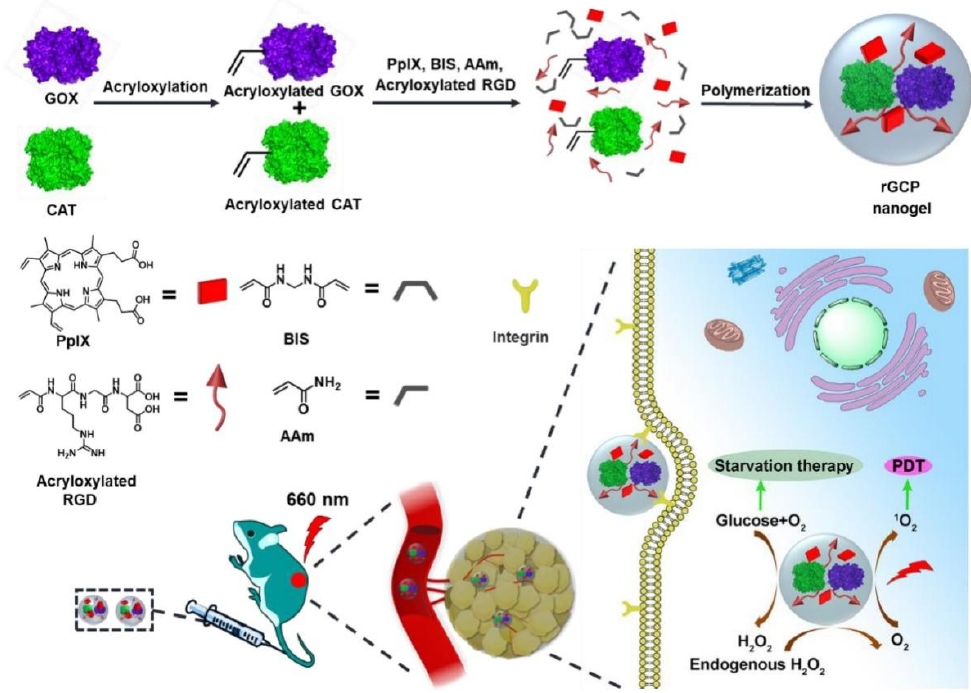
Figure 13. Schematic illustration of enzyme-immobilized nanogels for synergistic PDT and starvation therapy. Reprinted with permission from [261].